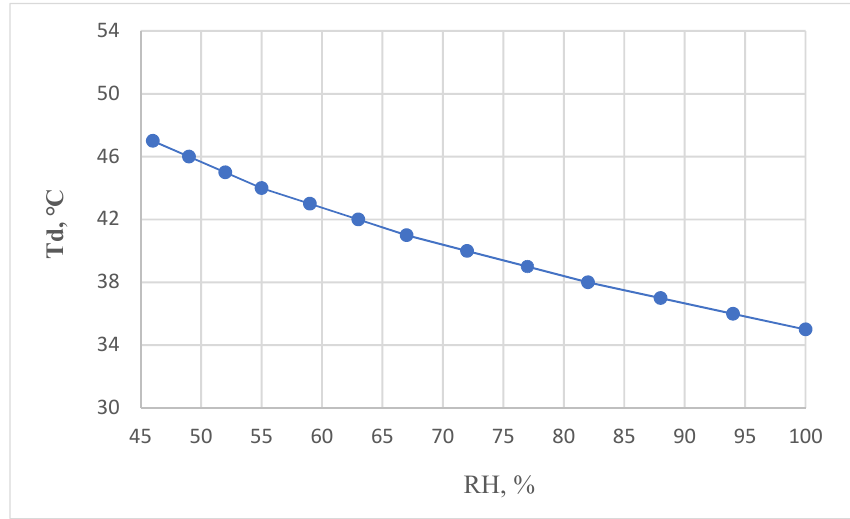
Figure 5. The error distribution for Model II.